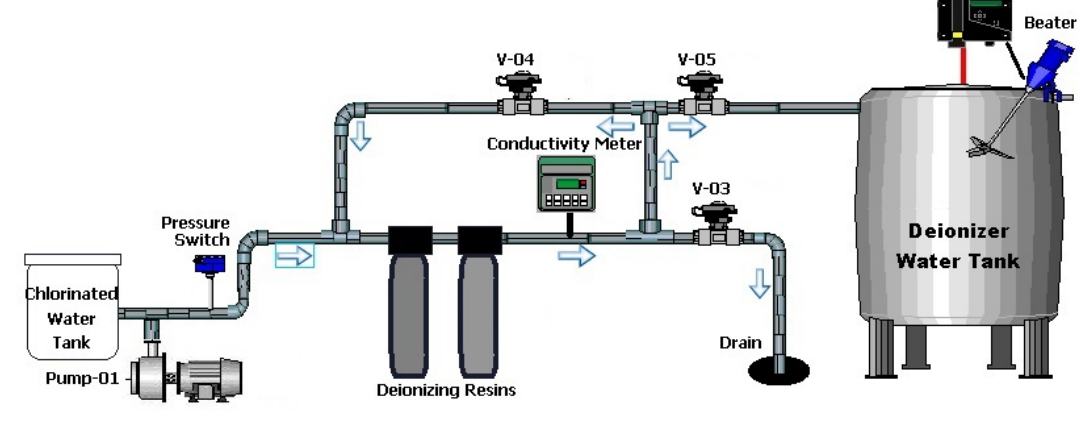
Figure 2. Deionization